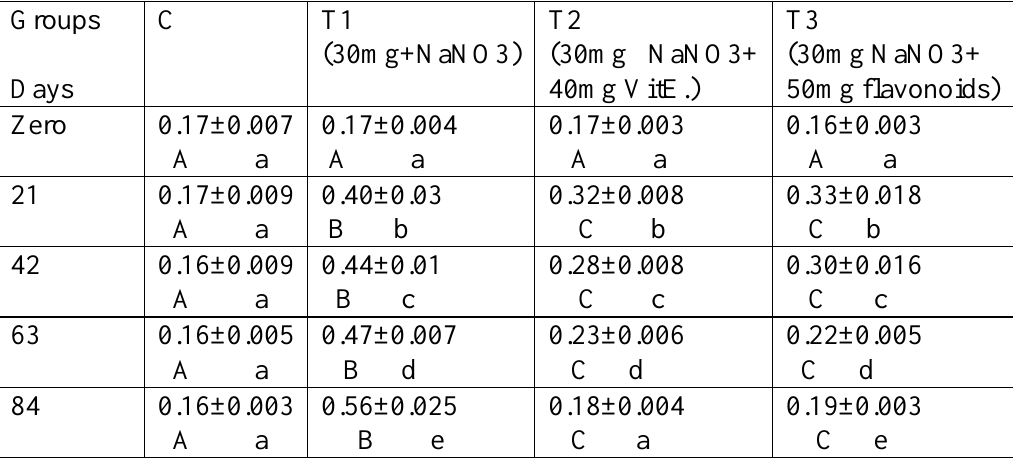
Table (4): Effect of sodium nitrate, vitamin E and flavonoids extracted from Nigella Sativa on serum bilirubin concentration (mg/dl) in male